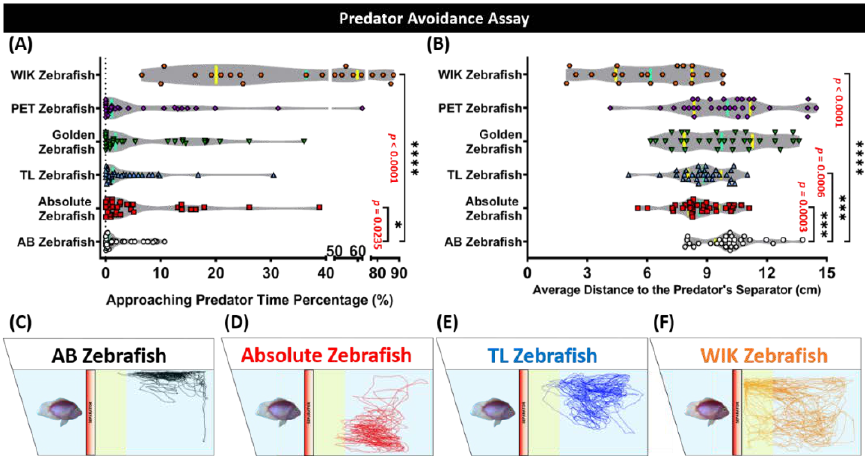
Figure 3. Predator avoidance behavior endpoint comparisons between the AB zebrafish (white), absolute zebrafish (red), TL (Tübingen Long Fin) zebrafish (blue), golden zebrafish (green), PET (Pet Store-purchased) zebrafish (purple), and WIK (Wild Indian Karyotype) zebrafish (orange). ( A ) Approaching the predator time percentage and ( B ) the average distance to the predator’s separator were analyzed for the predator avoidance assay. The median and the interquartile for the violin plot were labeled with the bold line colored with cyan and yellow, respectively. The 5-min locomotor trajectories for the AB, absolute, TL, and WIK zebrafishes are presented in ( C – F) , respectively, with the yellow colored zone as the approaching predator region. The data were analyzed by a Mann– Whitney test ( n = 30 for each group, except for the WIK zebrafish ( n = 21); * p < 0.05; *** p < 0.001; **** p < 0.0001).